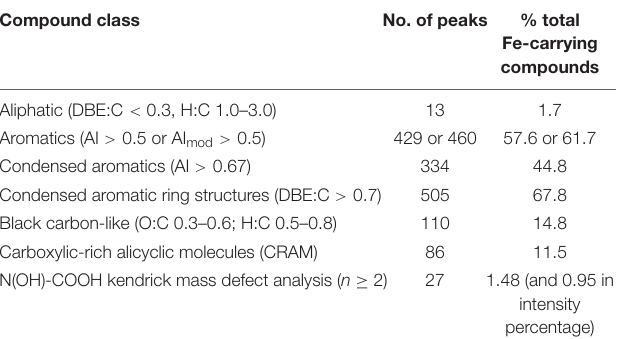
TABLE 3 | Compound classification of assignable Fe-containing peaks at all depths (CRAMs were defined as molecules having DBE: C 0.30–0.68, DBE: H 0.20–0.95, and DBE: O 0.77–1.75, percentage is calculated by number of each class to the total number of formulas, i.e.,